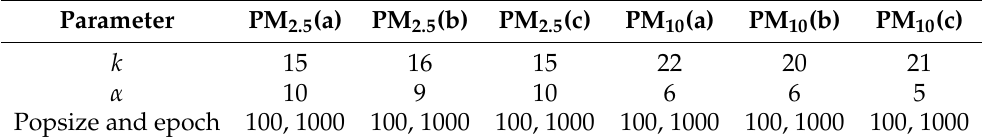
Table 3. Parameter settings of DNR for each air quality dataset.